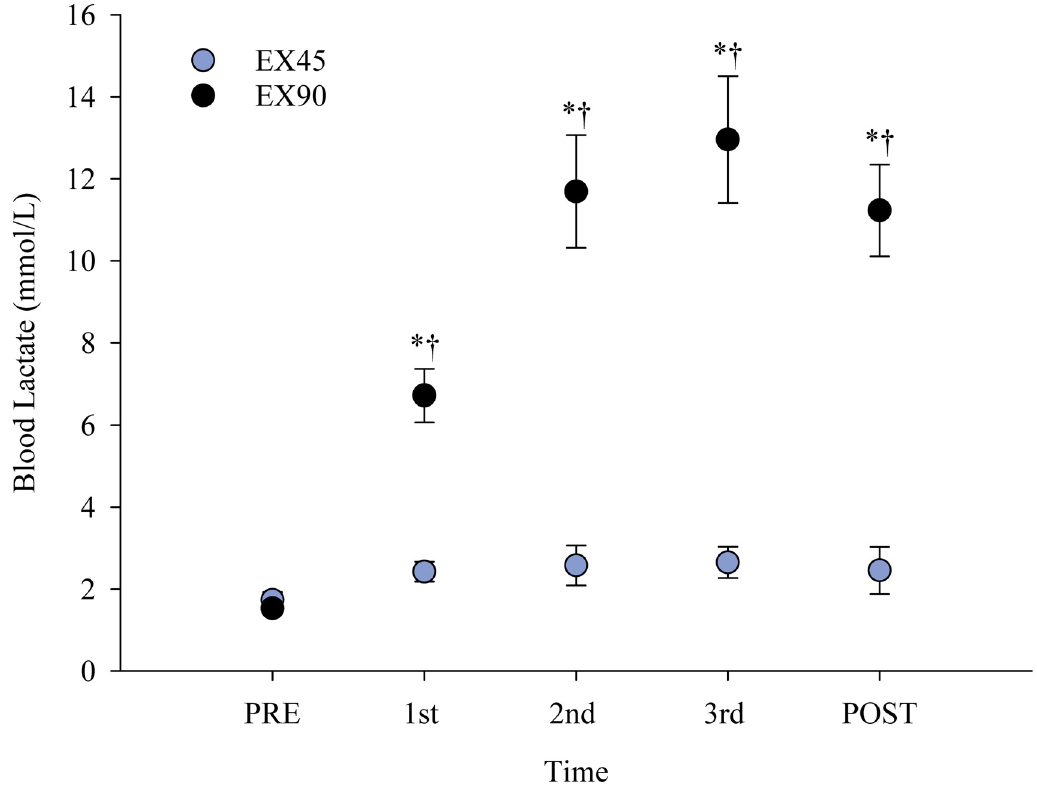
Fig 3. Blood lactate levels. Mean blood lactate levels (mmol/L) for the low (EX45) and high (EX90) intensity exercise groups ( ± SEM) at time points PRE, interval 1, 2 & 3 and 5 min POST exercise. * Significant difference compared to PRE values. † Significant inter-group difference at time point (p <